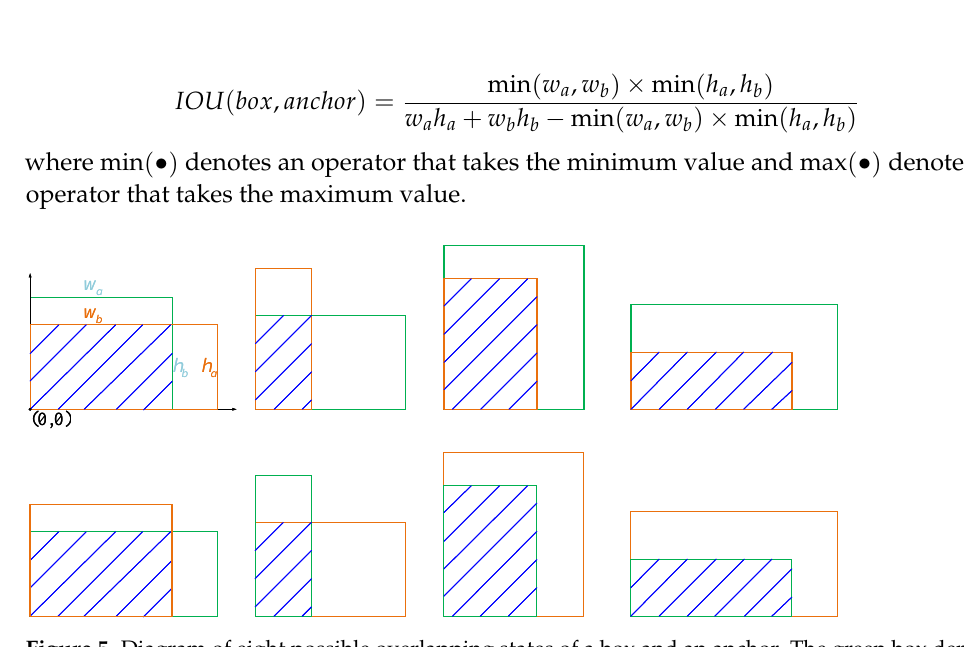
Figure 5. Diagram of eight possible overlapping states of a box and an anchor. The green box denotes the bounding box, the brown box denotes the anchor, and the blue shadow is the overlapping area of the bounding box and the anchor. When calculating the IOU, we ignore the position of the bounding box, and we assume that the lower right vertices of all bounding boxes are at the origin ( 0,0 )